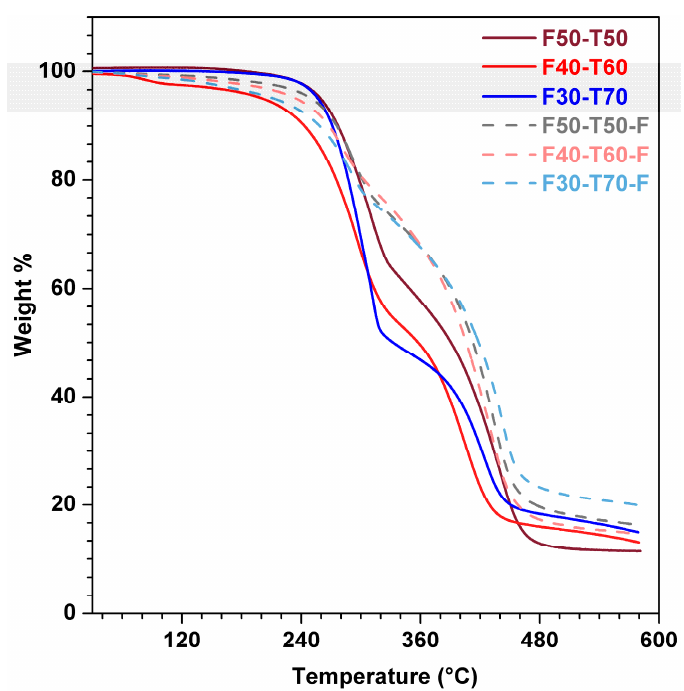
Figure 6. TGA (thermogravimetric analysis) plots of the powder and film samples.